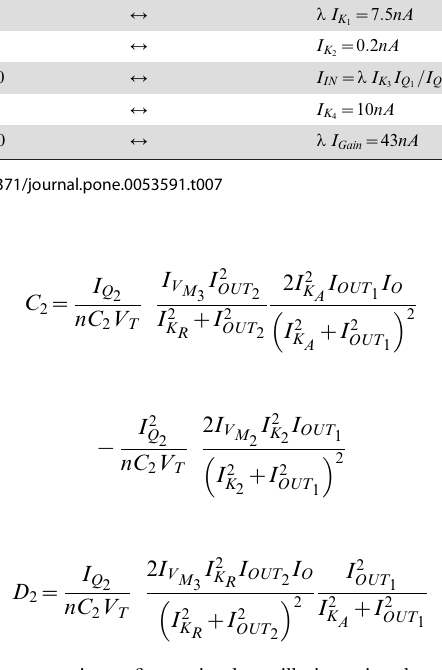
For the generation of sustained oscillations in the electrical equivalent system, the same conditions as in the biochemical model case should apply for the electrical eigenvalues. The equation that defines the electrical region of oscillations has been generated by setting the electrical trace ( A 2 z D 2 ) equal to zero and is also codified in Table 3. The region of oscillations of the electrical equivalent model corresponds to the right shaded area presented in Figure 8.